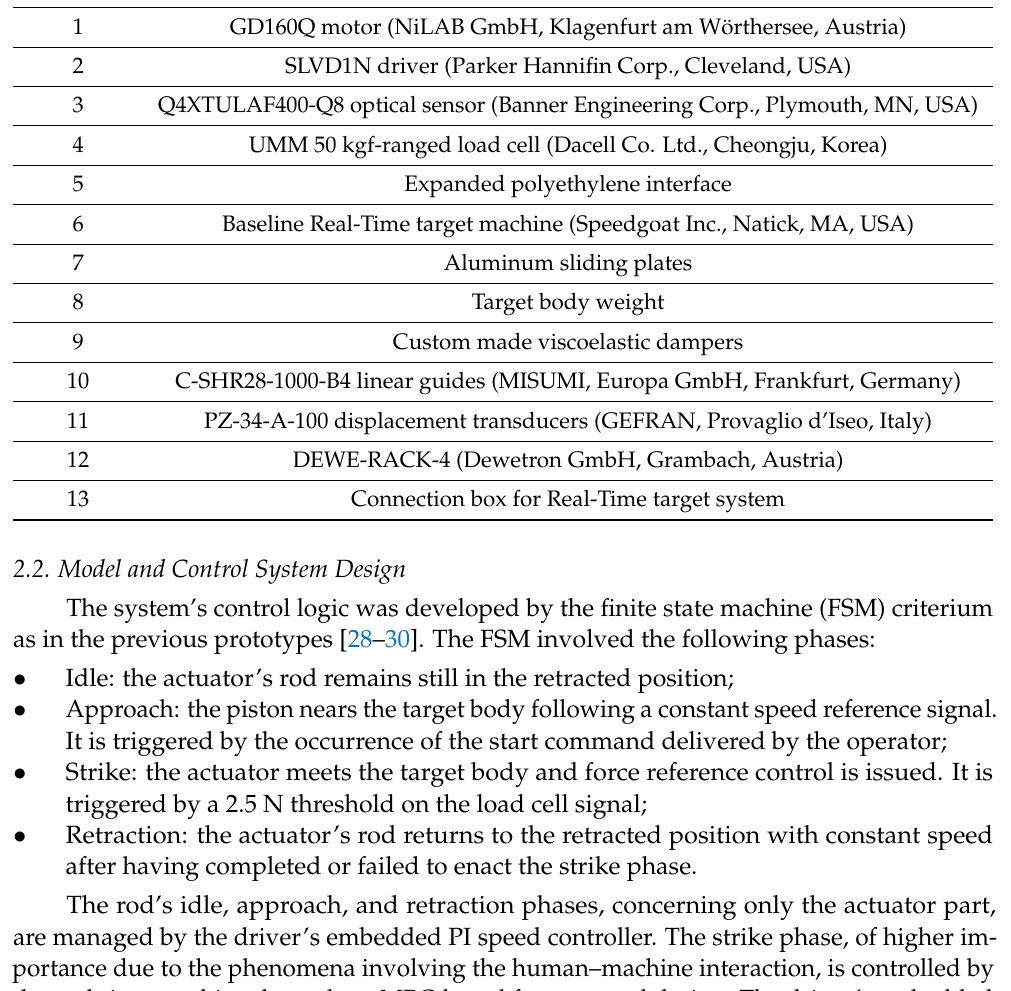
Figure 1. ( a ) Test bench model in SolidWorks environment; ( b ) test bench specimen; ( c ) example of experimental trial. Table 1. List of test bench key components for HIL testing. Numbers refer to labels in Figure 1. Num-